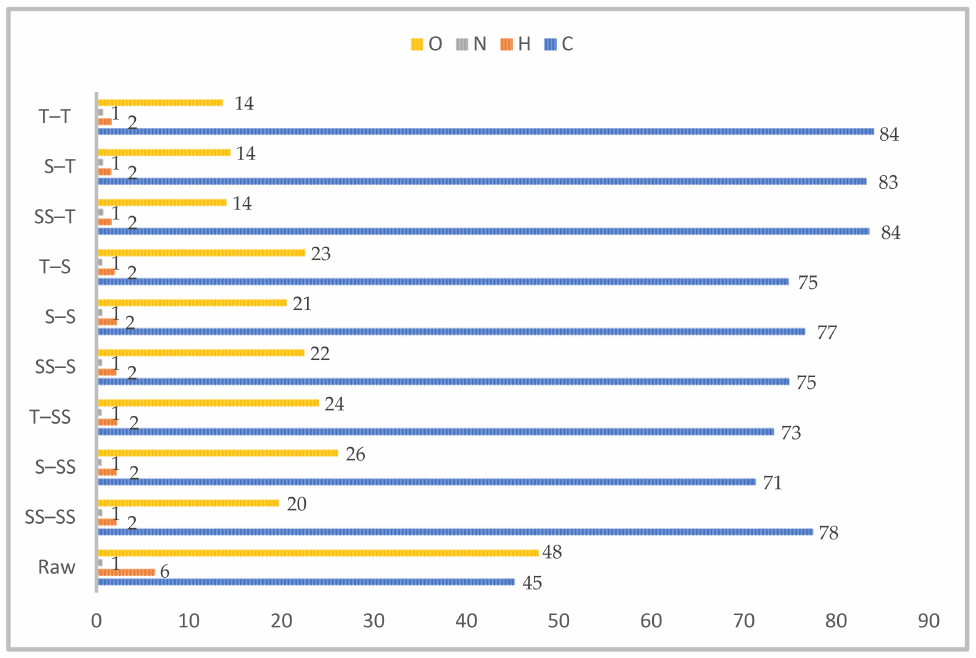
Figure 1. Elemental composition of C, H, N, O in raw and activated